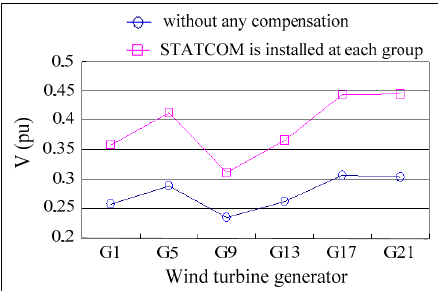
Figure 17. Comparison of the generator voltage with a STATCOM installed at D1 – D6 of each group.